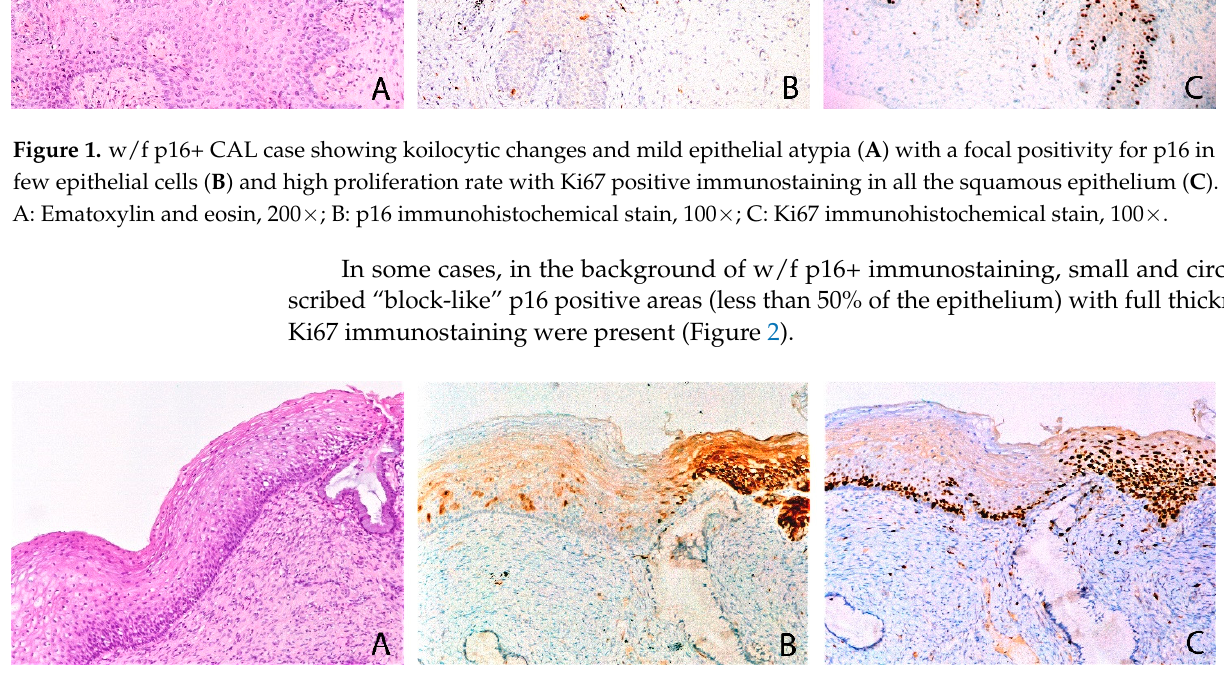
Figure 2. w/f p16+ CAL case with mild epithelial atypia ( A ) characterized by weak and patchy p16+ immunostaining in contiguity to a circumscribed “block like” p16 positive area ( B ), the latter with full thickness Ki67 immunostaining ( C ). A: Ematoxylin and eosin, 100×; B: p16 immunohistochemical stain, 100×; C: Ki67 immunohistochemical stain, 100×.